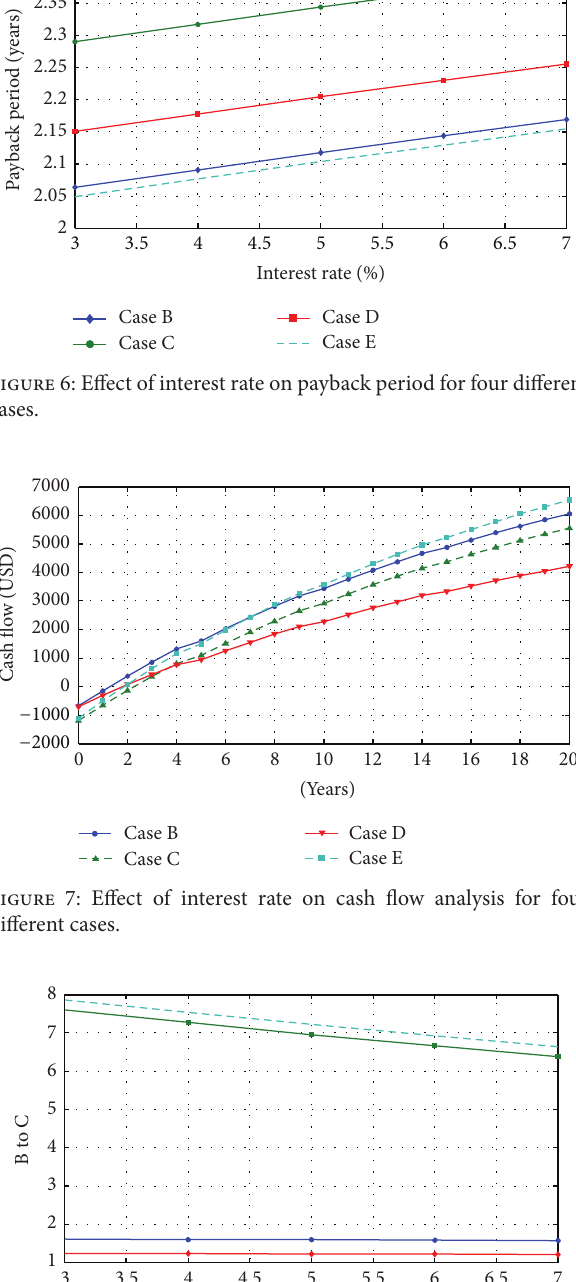
Table 1: Economic factors to determine financial feasibility.